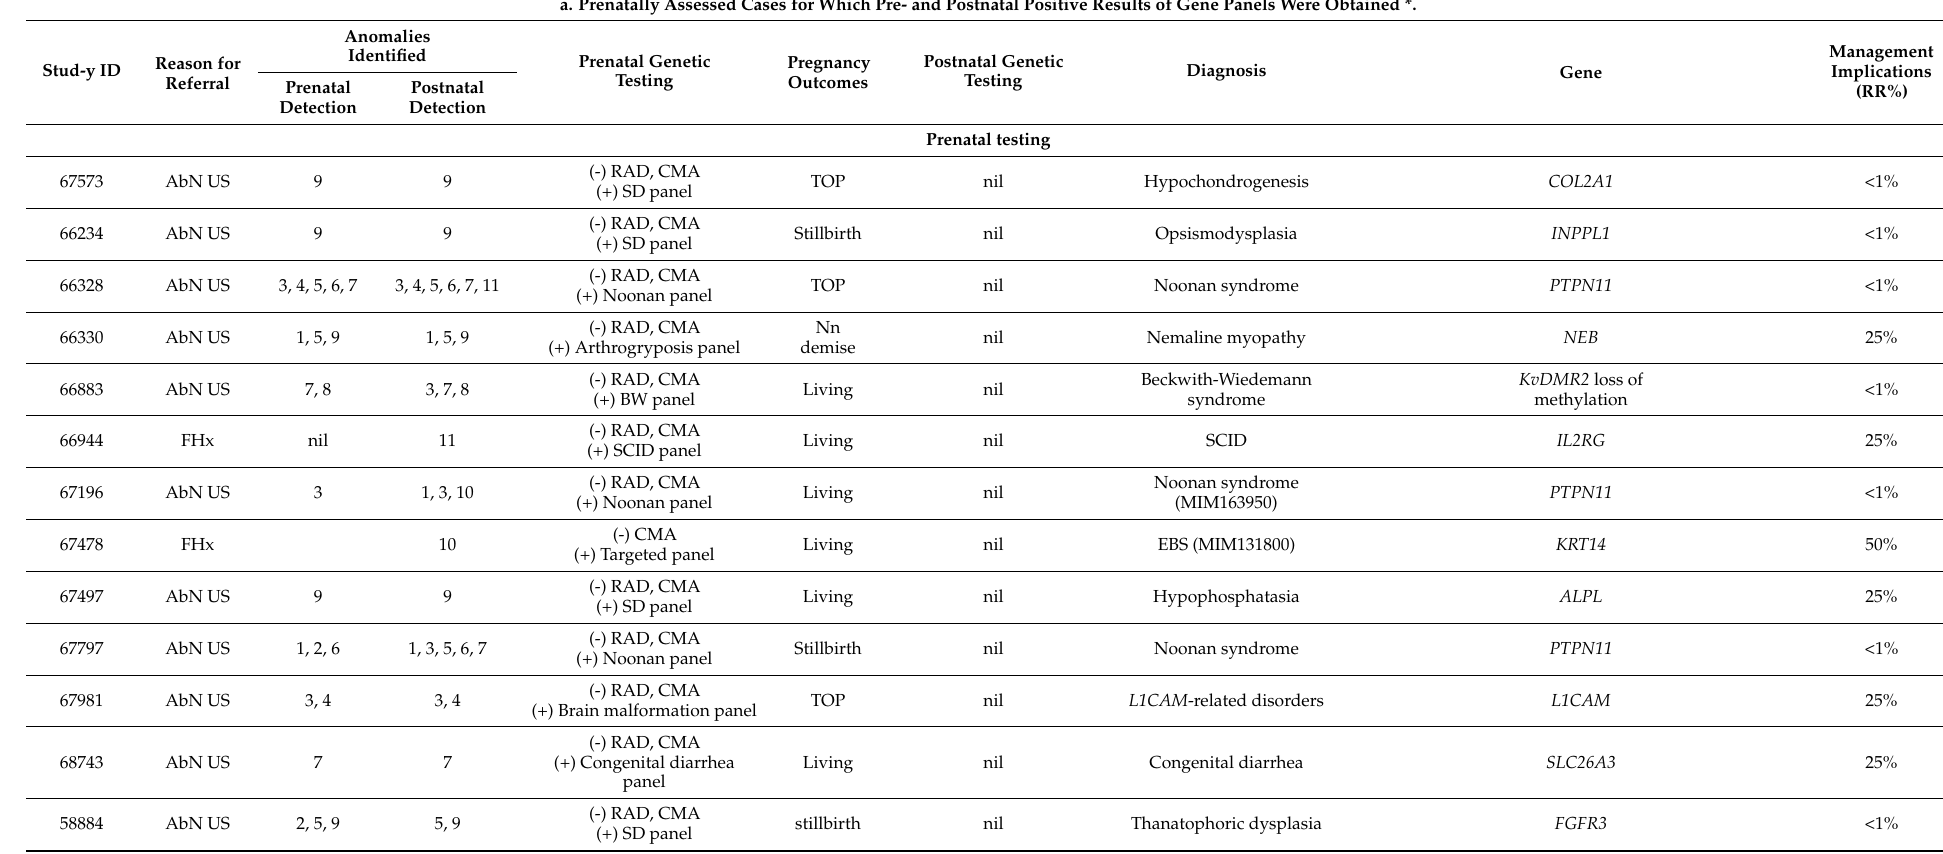
Table 1. Prenatal assessed cases. Data of both prenatal and postnatal panel testing were